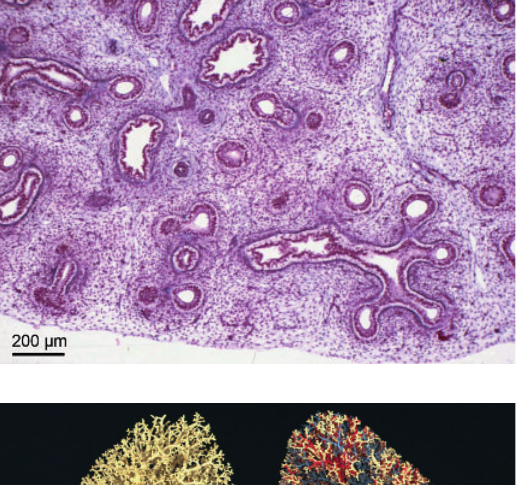
A resin cast of the human airway tree shows the dichoto- mous branching of the bronchi from the trachea and the sys- tematic reduction of airway diameter and length with progres- sive branching. In the left lung the pul- monary arteries ( red ) and veins ( blue ) are also shown.